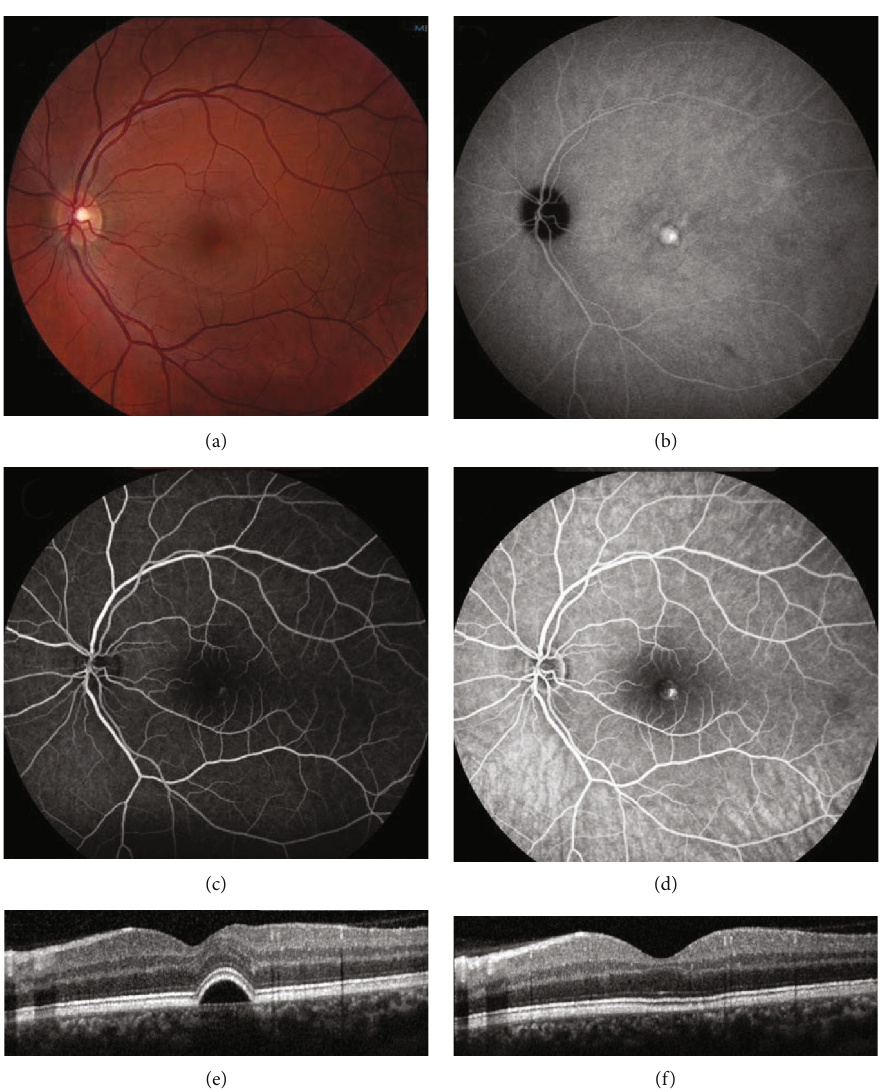
Figure 10: Chronic central serous chorioretinopathy treated with photodynamic therapy (PDT). A 35-year old male presented with 6 months of visual distortion in the left eye, although visual acuity was 20/20. (The amount of metamorphopsia was not formally measured.) He had tried 50mg of eplerenone daily for over one month without improvement. (a) Fundus photography showed pigment changes and a pigment epithelial detachment (PED). (b) Fundus auto fl uorescence showed an area of hyperauto fl uorescence corresponding to the PED. (c) Early-phase fl uorescein angiography (FA) showed a faint area of leakage in the macula. (d) Late-phase FA showed increased leakage in the macula. (e) Optical coherence tomography prior to and (f) after half- fl uence PDT showed resolution of the PED. Visual acuity remained 20/20 and the patient reported subjective